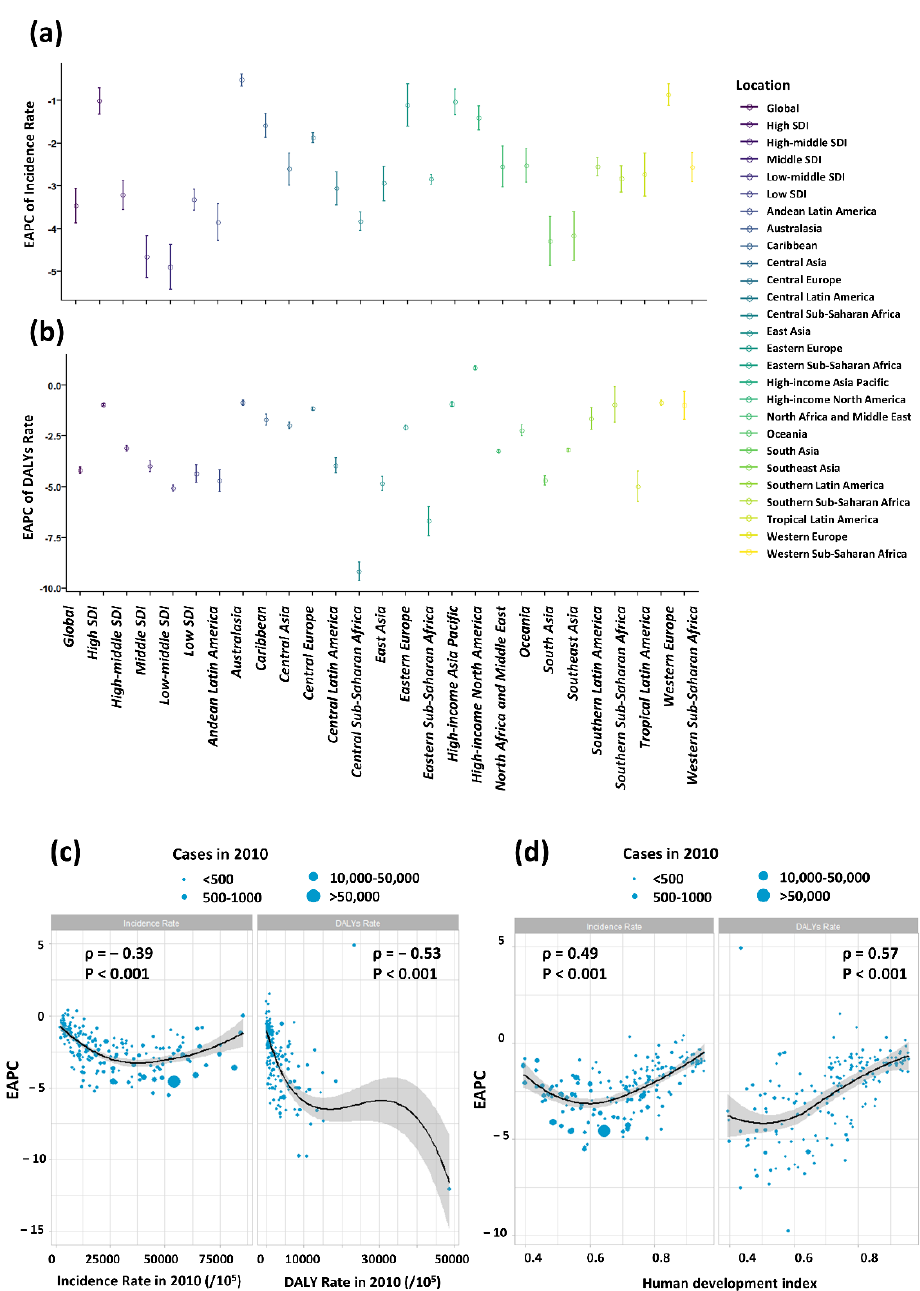
Figure 5. The EAPCs of nutritional deficiencies at global, regional and national level. ( a ) The EAPC of nutritional deficiencies incidence from 2010 to 2019, both sexes, by region and by causes; ( b ) The EAPC of nutritional deficiencies DALYs rate from 2010 to 2019, both sexes, by region. The correlation between EAPC and ( c ) of nutritional deficiencies and DALYs rate in 1990 and ( d ) HDI in 2019. The circles represent countries that were available on HDI data. The size of circle is increased with the cases of nutritional deficiencies cases. The ρ indices and p values presented in ( c , d ) were derived from Pearson correlation analysis.